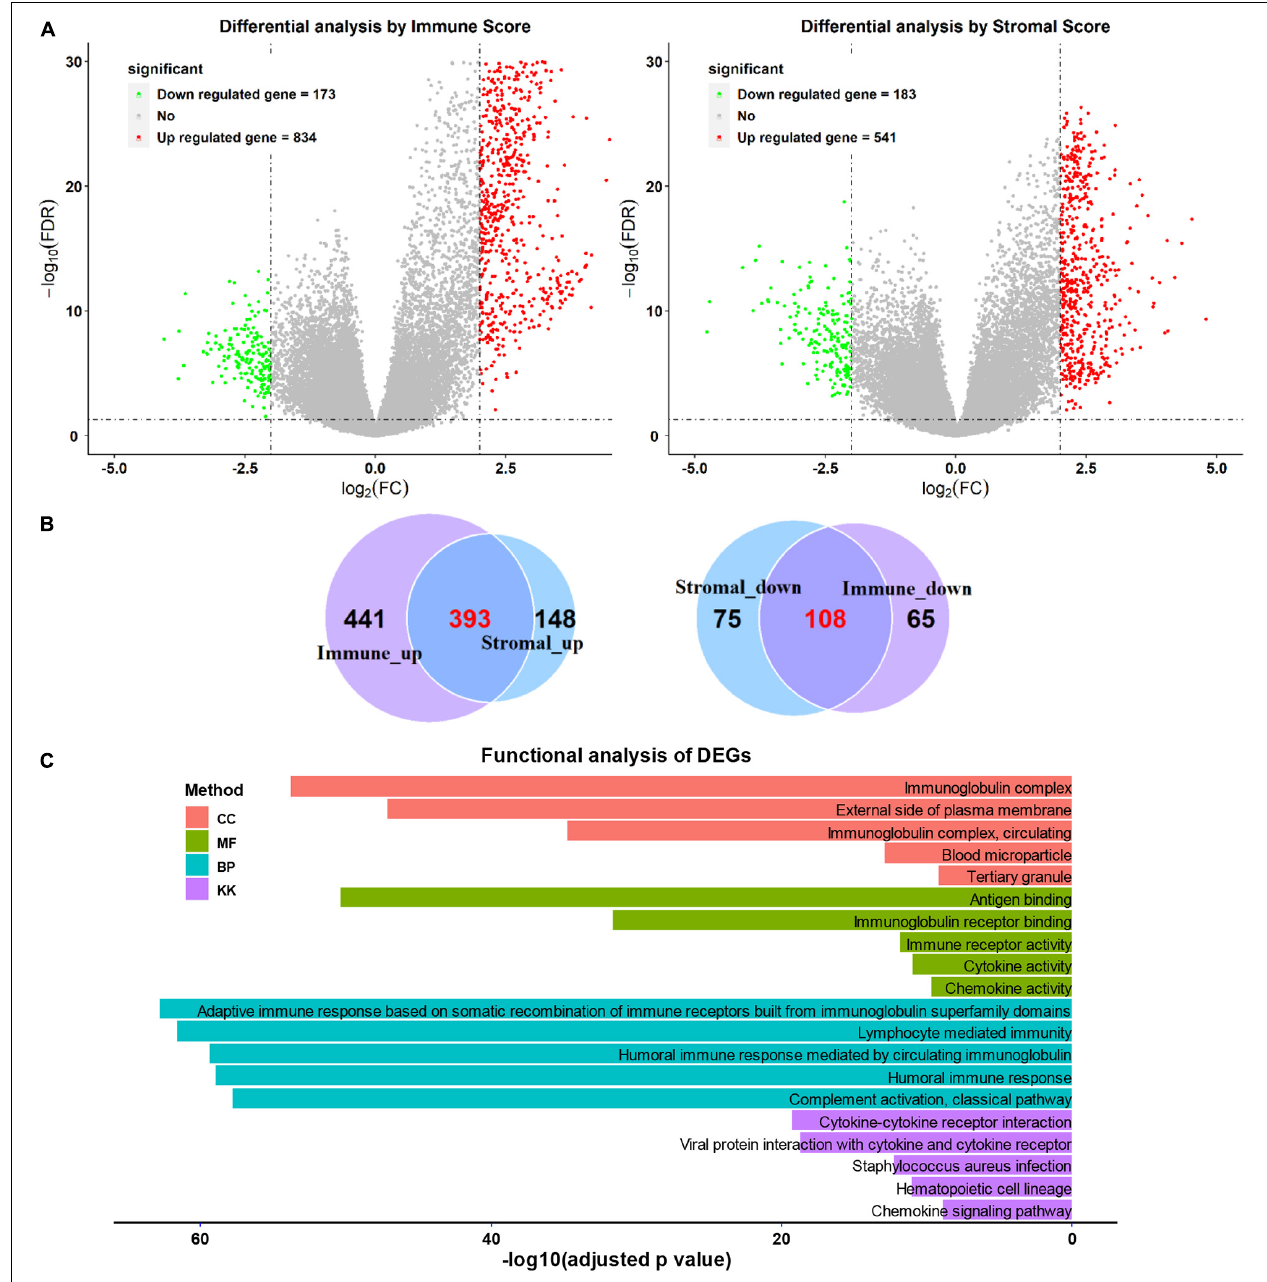
FIGURE 6 | Comparison of gene expression profiles with higher or lower immune scores or stromal scores in SARC. (A) The volcano plots were used to describe the differential expressed genes of immune scores and stromal scores. (B) The Venn plots were performed to reveal the intersections of up-regulated genes and down-regulated genes. (C) The top GO analyses terms and KEGG pathways terms enriched by the intersect